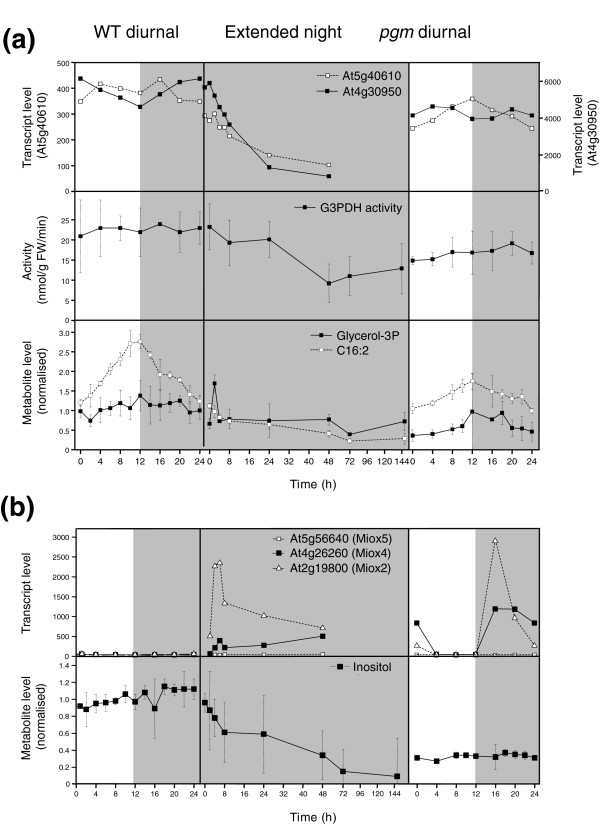
Details of specific changes in transcript levels, metabolites and enzyme activities during the diurnal cycle and an extended night. Changes in specific transcripts, enzyme activities and metabolites in rosettes of Arabidopsis Col0 WT plants (WT diurnal) and pgm (pgm diurnal) throughout a day and night cycle, and in WT transferred to an extended night. (a) Glycerolipid metabolism: levels of transcripts encoding glycerol-3P dehydrogenase (At5g40610) and fatty acid desaturase 6 (At4g30950), activity of glycerol-3P dehydrogenase, and levels of glycerol-3P and palmitolenate. (b) Inositol metabolism: levels of transcripts encoding inositol oxidase (At5g56640, At4g26260 and At2g19800), and inositol levels. FW, fresh weight.